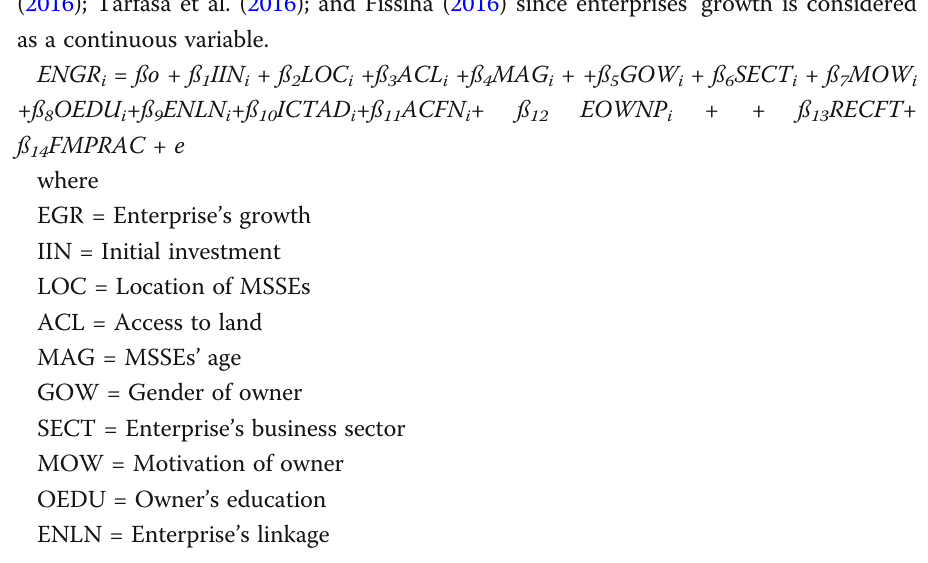
Table 2 Nature and measurement of variables No. Variable Notation Nature Measurement Growth Employment EMPLGR Continuous Change in employment size between the years of rate growth rate beginning and sampling periods divided by age of the enterprise Capital growth rate